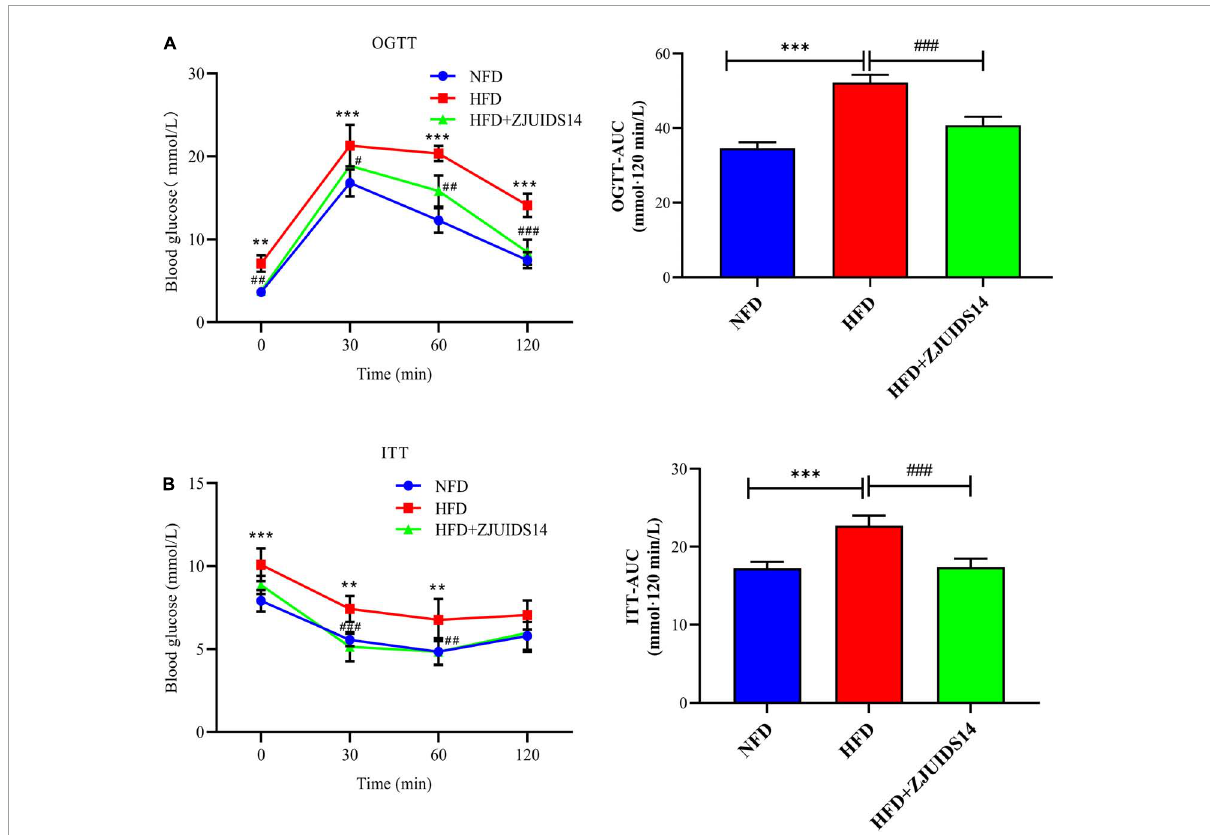
FIGURE2 Lactobacillus plantarum ZJUIDS14 administration reduces insulin resistance in HFD fed mice. (A) Oral glucose tolerance tests (OGTT) and (B) insulin tolerance tests (ITT). ∗∗ P < 0.01, ∗∗∗ P < 0.001 vs NFD group; # P < 0.05, ## P < 0.01, ### P < 0.001 vs HFD